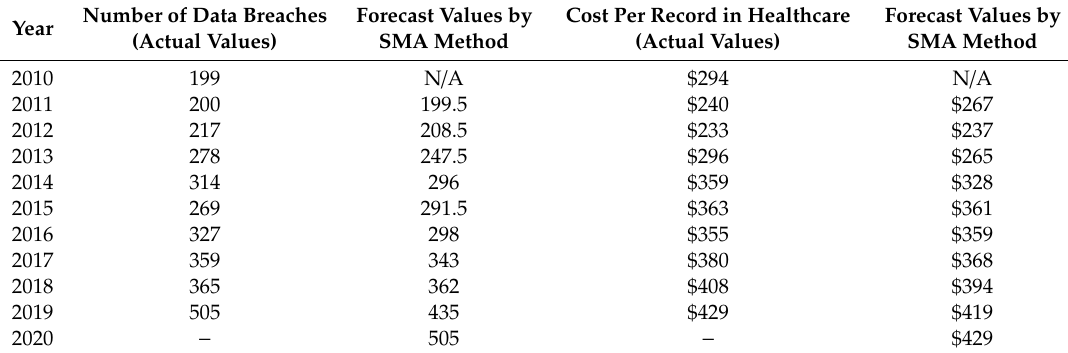
Table 8. Healthcare Data Breach Forecasting through SMA method.